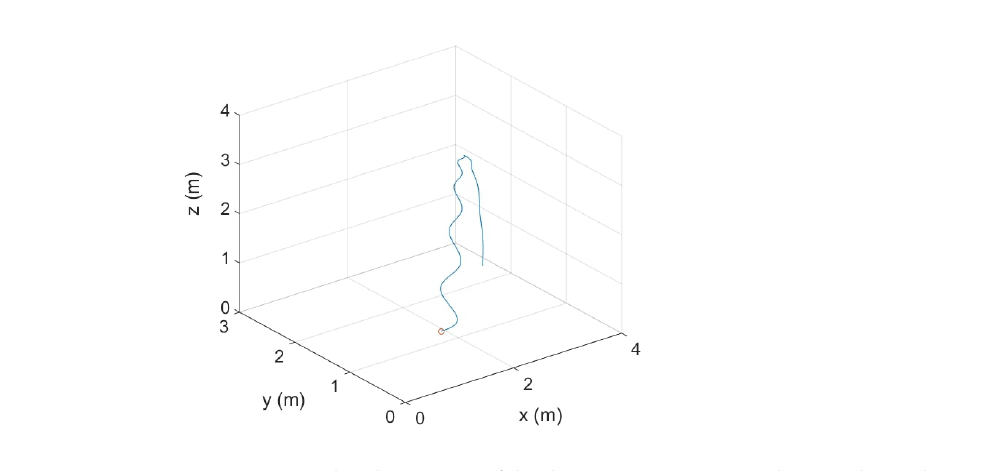
Figure 11. Simulated trajectory of the drone in Cartesian coordinates (the circle represents the starting position of the drone). Table 2. Steering errors: mean ( µ ) and standard deviation ( σ ) for the azimuth ( ϕ ) and elevation ( θ ) in the simulated and experimental trajectories.